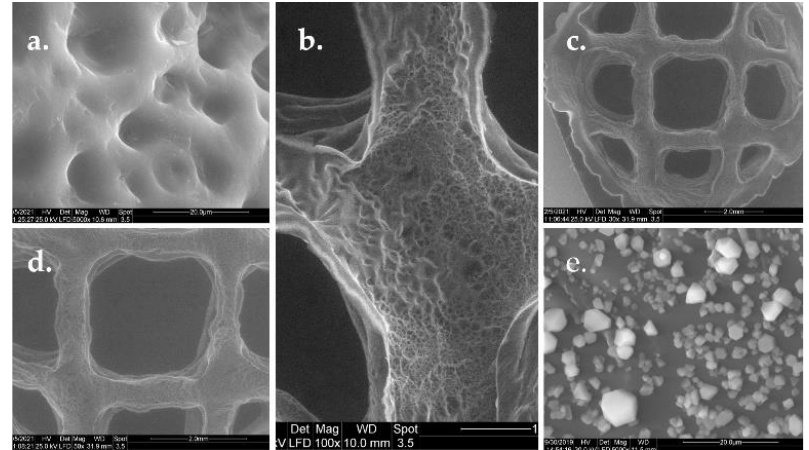
Figure 7. SEM images showing the microstructure aspect of: ( a ) Nonmineralized GelMA scaffold at mag. 5000×, ( b ) 100×, ( c ) 30×, and ( d ) 50×; ( e ) mineralized GelMA scaffold at mag. 5000× with scale bar of 20 μm.